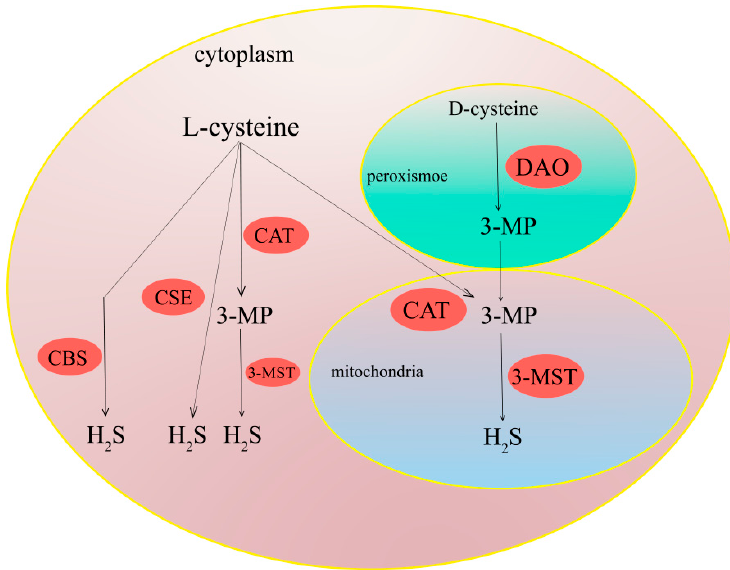
Figure 2. Pathway of H 2 S production in mammalian cells.